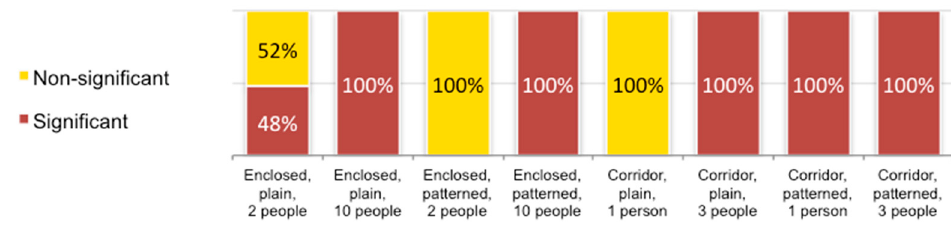
Figure 4. Percentage of participants with significant/non-significant size variations for each space in age range perception filter.